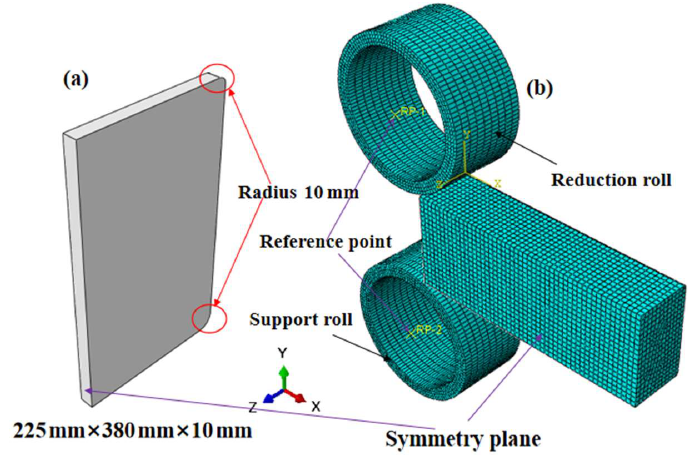
Figure 2. Solidification heat transfer model and cast-rolling model: ( a ) Geometric model of the slice, ( b ) Reduction finite-element of the bloom.